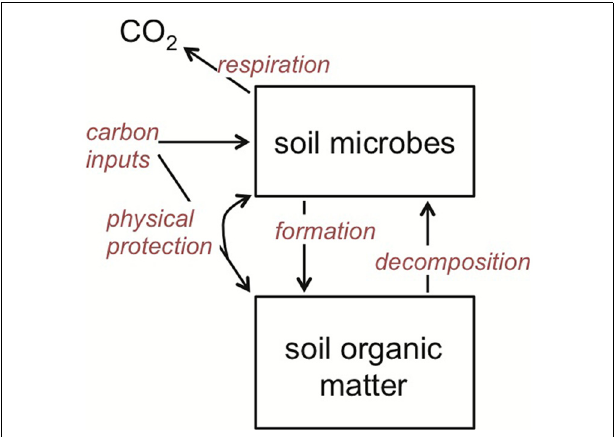
FIGURE 2 |Theoretical framework for soil organic matter (SOM) dynamics, emphasizing the central role that soil microbes play in both SOM decomposition and formation. The rate of all of the processes (red italics) is temperature dependent, and hence stock sizes of SOM will be dependent on how warming affects the rate of each relative to one